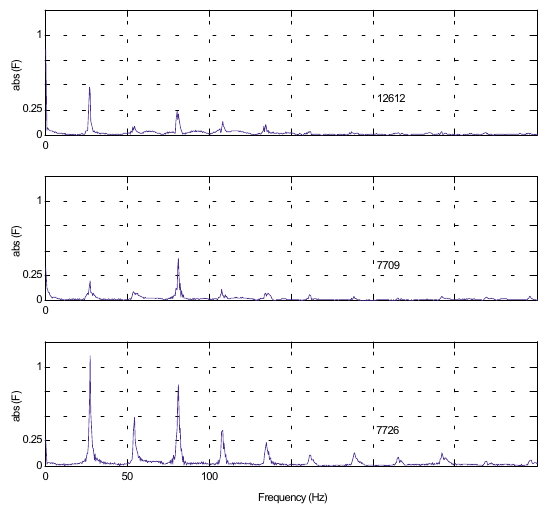
Fig. 5. Magnitude of the Fourier transform of the signals in Fig.